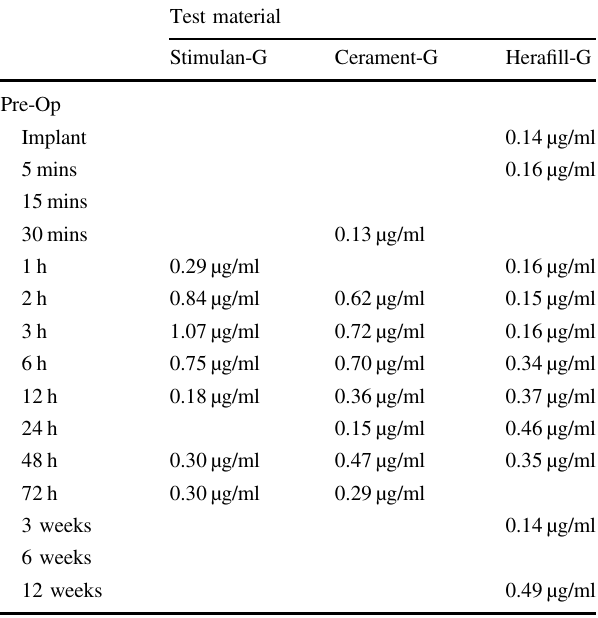
Table above represents a summary of gentamicin levels for each test material group at each of the blood sampling intervals (µg/ml). Data was averaged for all the animals within each blood sampling interval. Empty spaces indicate no detection of gentamicin across any specimens treated within a speci fi c test material